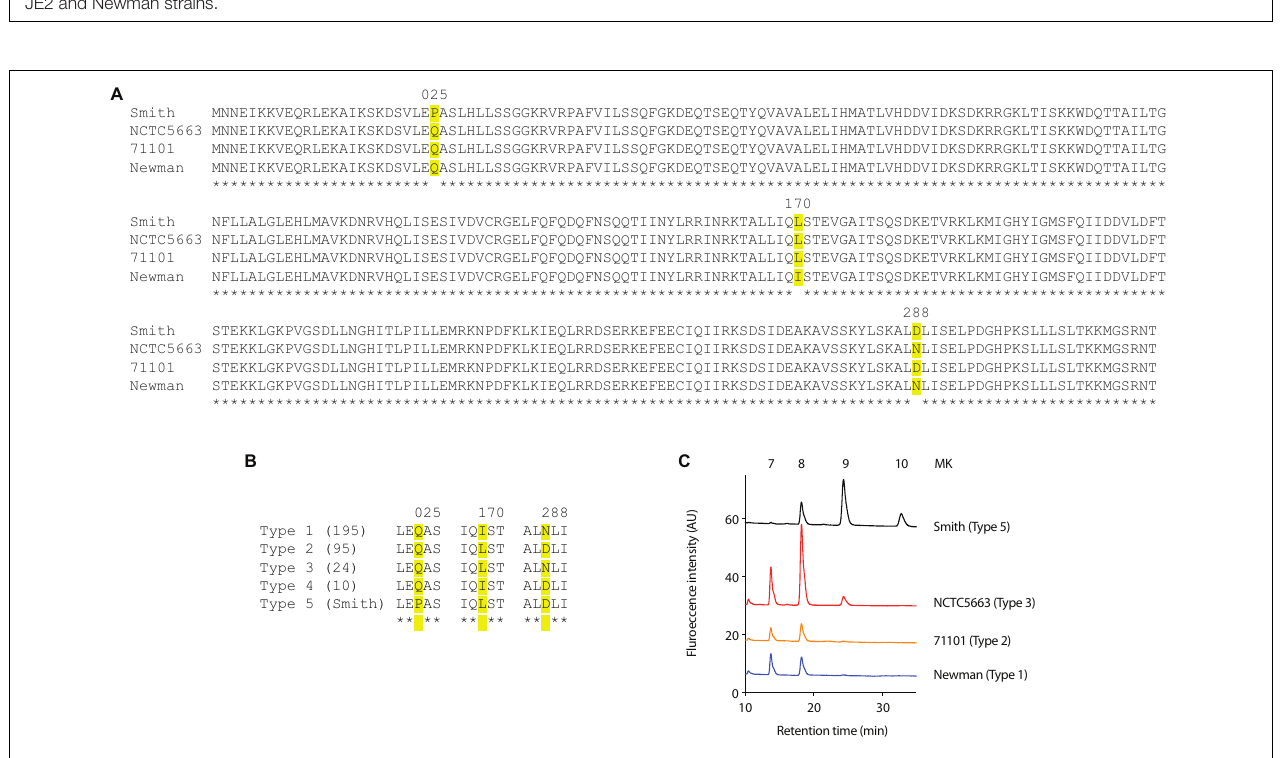
FIGURE 3 | The classical MK biosynthetic pathway in S. aureus Smith. The highlighted enzymes have an end to end sequence identity between S. aureus Smith, JE2 and Newman strains.